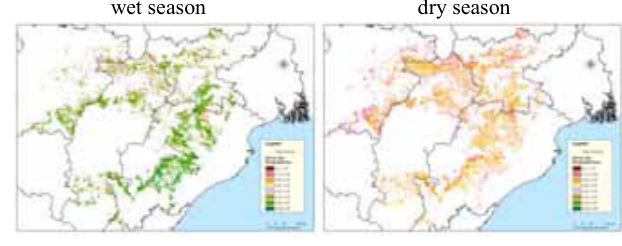
temperature variability. This exponential re